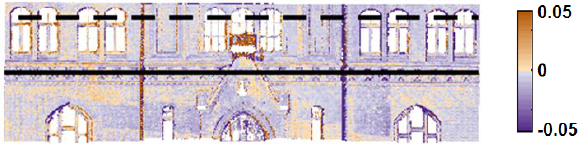
Figure 12. DIM from terrestrial and UAV imagery: Deviations DIM-TLS of façade 1